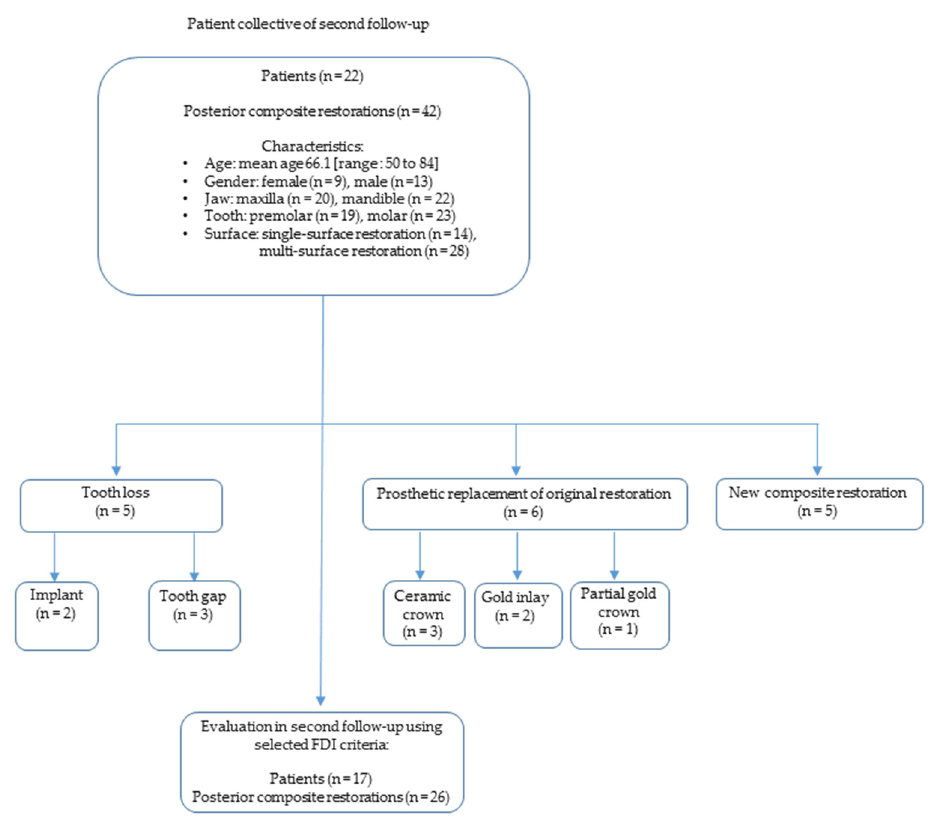
Figure 2. Flow diagram: patient collective of second